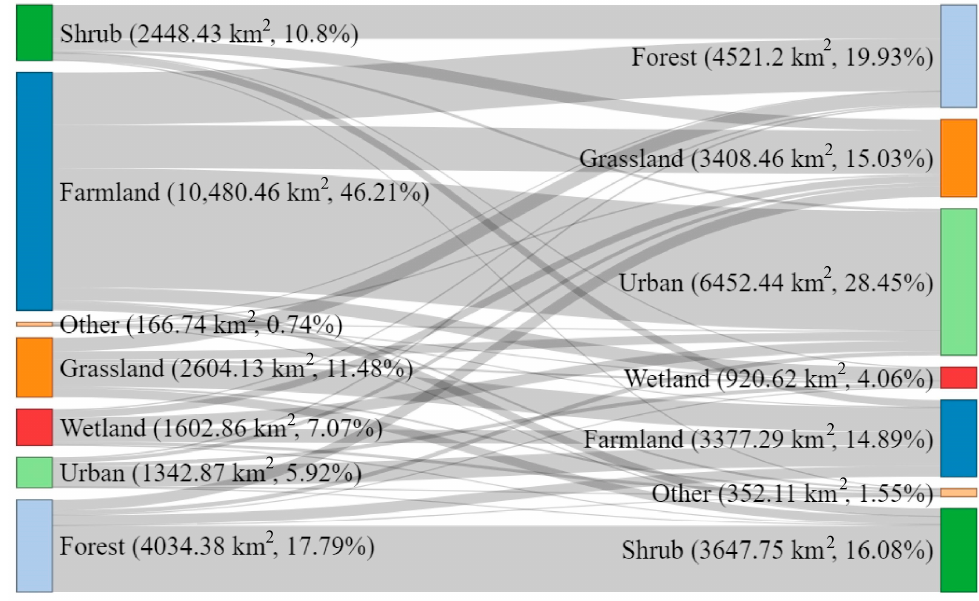
Figure 6. Schematic diagram of the transition of ecosystem types in the Beijing–Tianjin–Hebei urban agglomeration from 2000 to 2015. Table 2. Ecosystem degradation of the Beijing–Tianjin–Hebei urban agglomeration from 2000 to 2015.